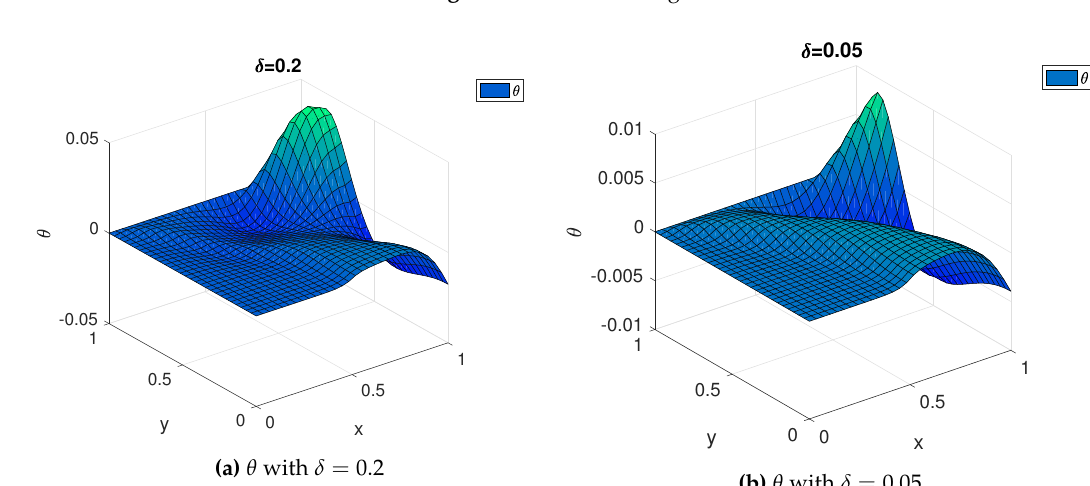
Figure 5. θ for decreasing δ .